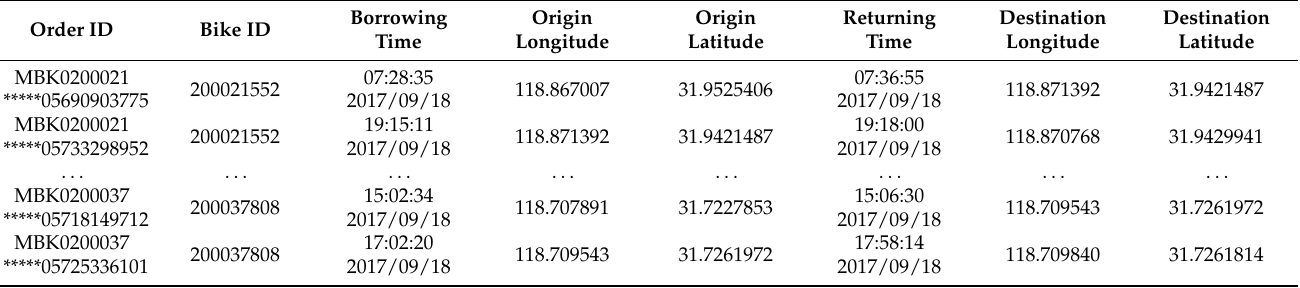
Table 1. Example of bike-sharing riding